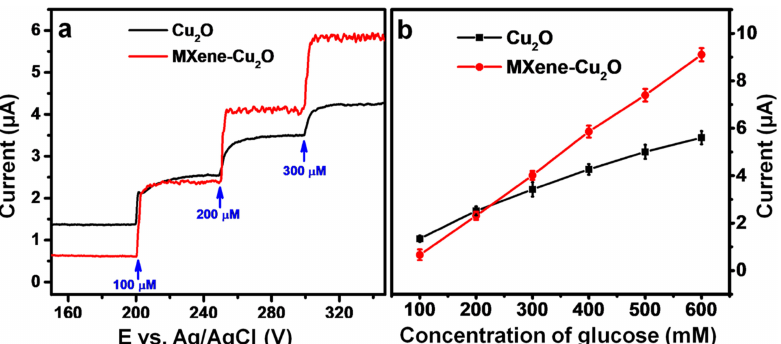
Figure 7. ( a ) Chronoamperometry response and ( b ) Glucose concentration versus current for Cu 2 O and MXene-Cu 2 O composite. Reprinted with permission from Ref. [82].